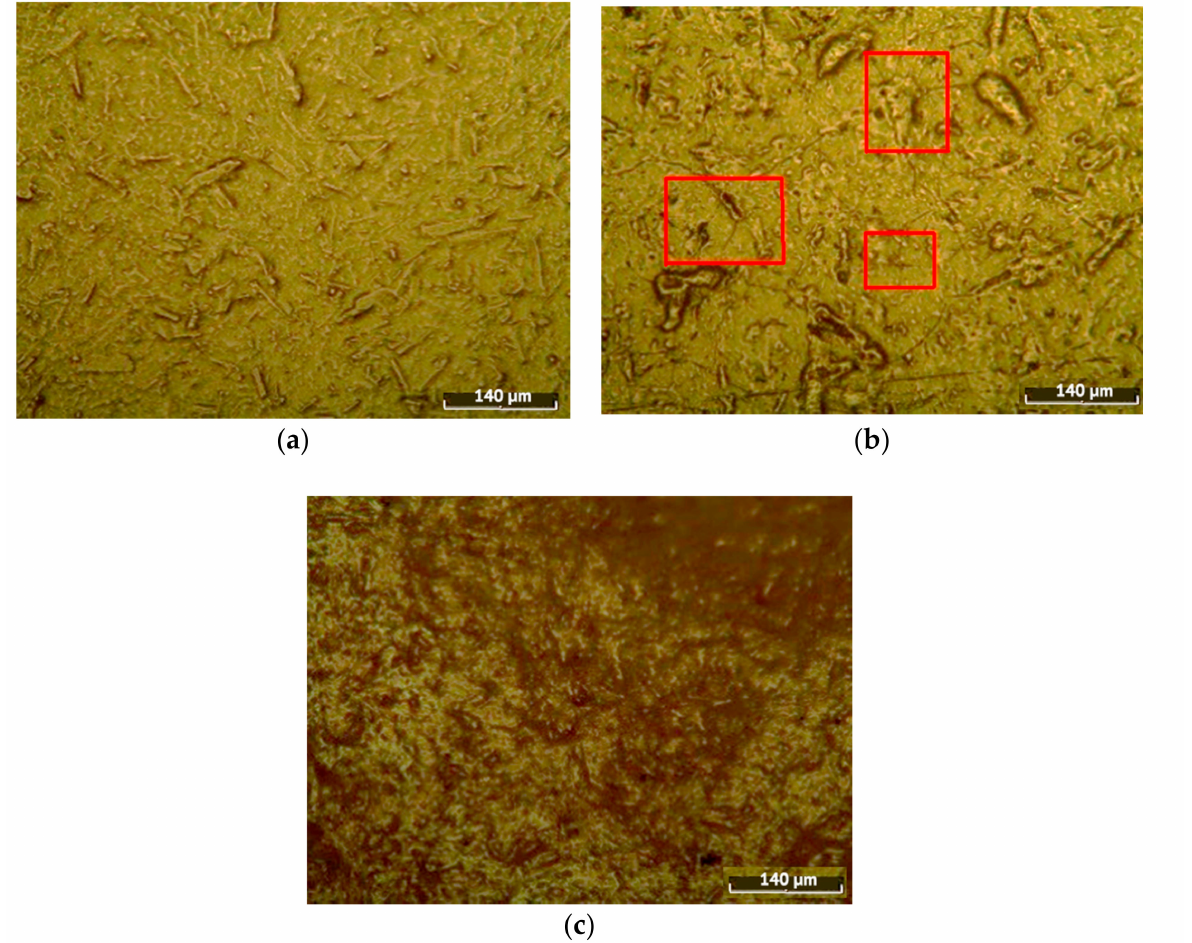
Figure 17. The microstructure of the coating got on the longitudinal strip selected from the coatings after decompression tests, × 100: ( a ) witness sample; ( b ) a sample tested at + 70 ◦ C; ( c ) a sample tested at +90 ◦